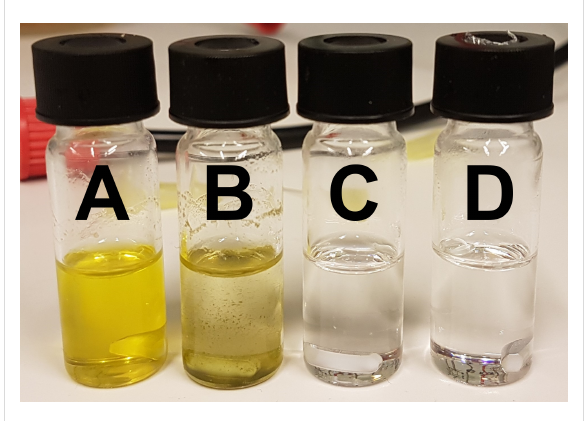
Figure 4: Reaction mixtures after overnight irradiation of (A) 4-chloro- 4-phenylbutanoic acid ( 3 ) and fac -[Ir(ppy) 3 ]; (B) 3 , fac -[Ir(ppy) 3 ] and monochloroacetic acid; (C) 3 ; (D) 3 and monochloroacetic acid. In none of the vials lactone 1 was